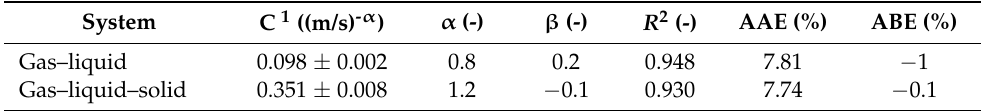
Table 9. Total gas holdup ε GT : Evaluated parameters of correlation